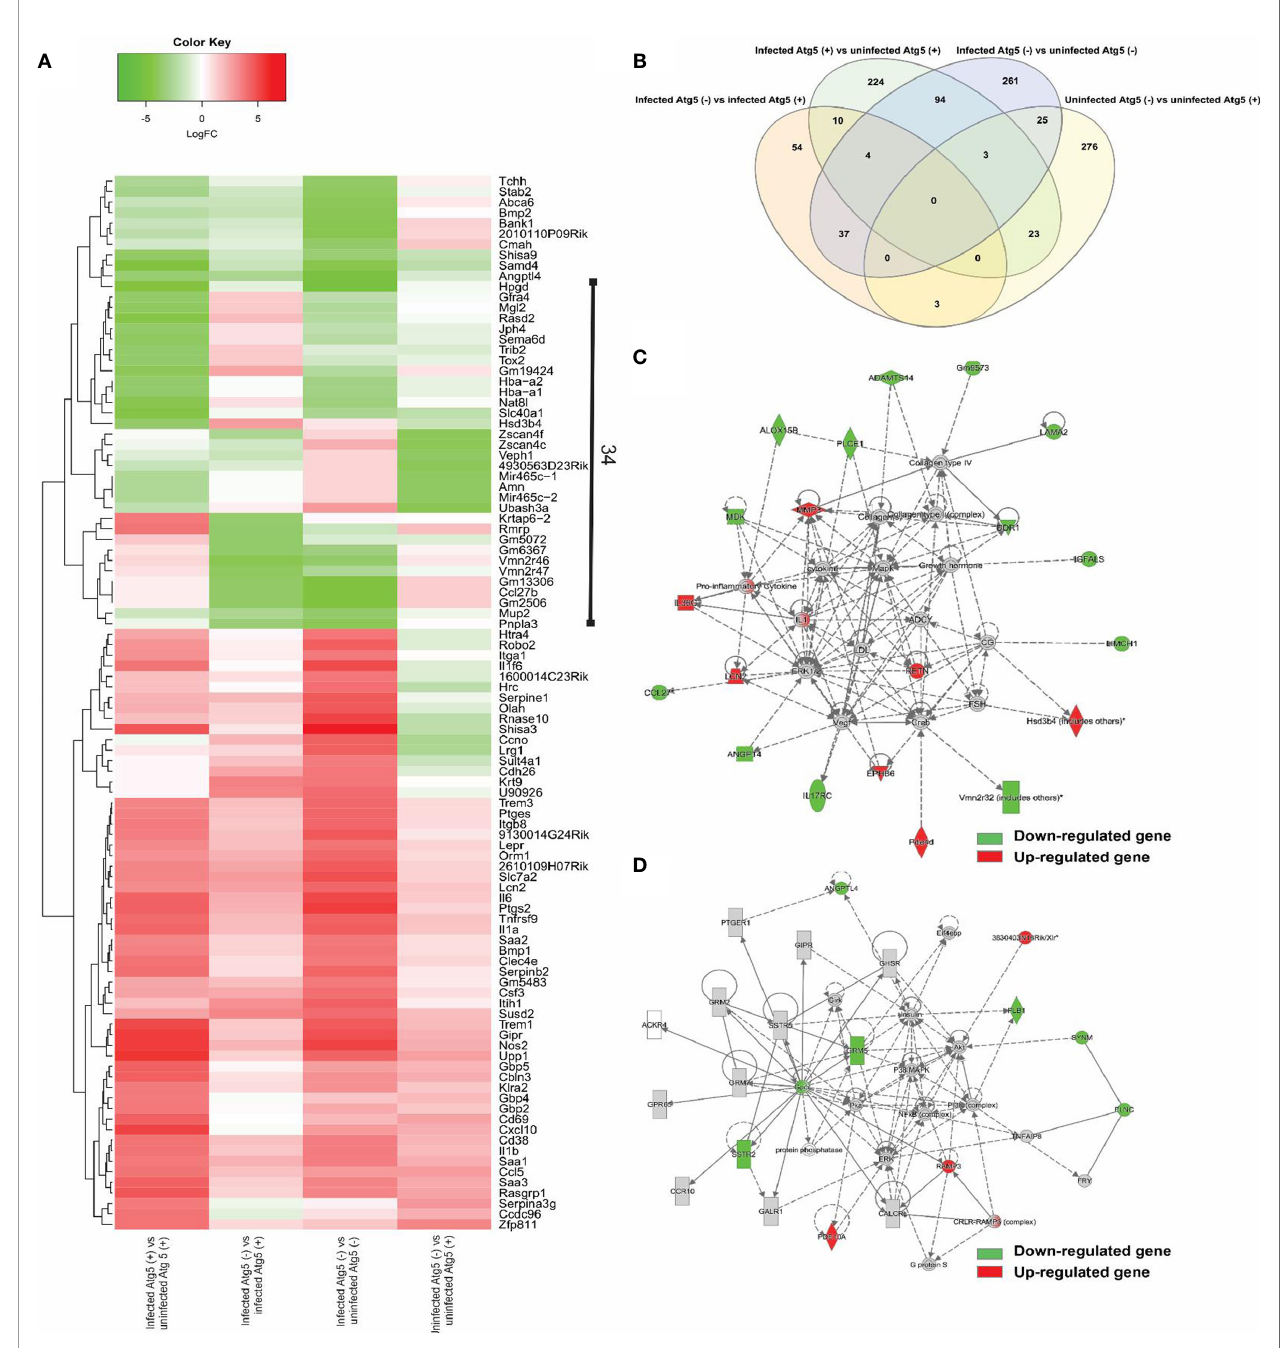
FIGURE 3 | (previous Figure 3). Comparative transcriptional analysis of R. australis -infected Atg5 fl ox/ fl ox Lyz- Cre and Atg5 fl ox/ fl ox BMMs. BMMs were isolated from Atg5 fl ox/ fl ox Lyz- Cre and Atg5 fl ox/ fl ox mice , and then infected with R. australis at an MOI of 5. At 24 h p.i., cells were collected and total RNA was extracted. RNA-seq analysis was performed as described in Materials and Methods . Atg5 (+), Atg5 fl ox/ fl ox ; Atg5 (-), Atg5 fl ox/ fl ox Lyz- Cre. (A) , Heatmap and hierarchical clustering of the top 100 genes differentially regulated by Atg5 during R. australis infection in mouse macrophages. The expression levels of genes are indicated by the color bar above the heatmap. Red color indicates the increased expression whereas green color indicates the decreased expression in four comparisons. (B) , Venn diagram showing overlap of signi fi cantly modulated genes for each of the four comparisons. (C, D) , IPA molecular networks analysis of differentially expressed genes in IL-1 family cytokines signaling and PI3K-Akt-mTOR signaling in R. australis -infected Atg5 fl ox/ fl ox Lyz- Cre BMMs vs R. australis -infected Atg5 fl ox/ fl ox BMMs. Red, up- regulated; green,